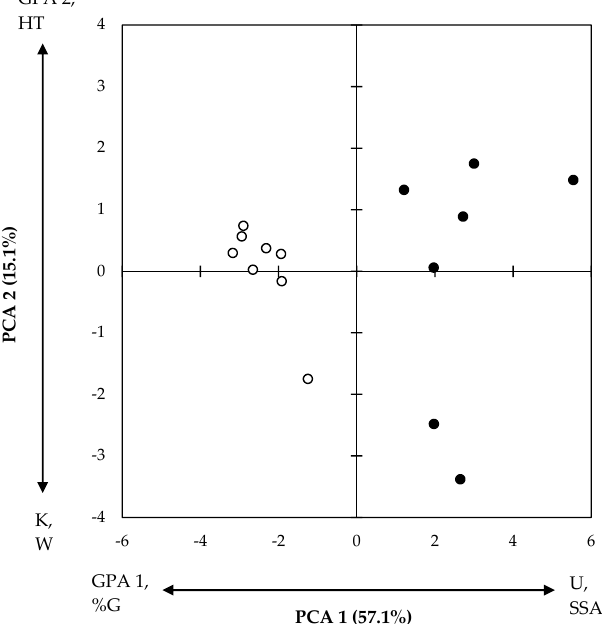
Figure 3. Position of individual sheep from the flystruck (closed) and non-flystruck (open) groups on the two main principal component analysis (PCA) dimensions characterised by Urine stain score (U), Size of flystruck area (SSA), GPA 1 (Positively occupied), Grazing (%G), Kicking (K), Walking (%W), GPA 2 (Inquisitive) and Head turning (HT). Complete loadings for PCA dimensions 1 and 2 are summarised in Figure 2.